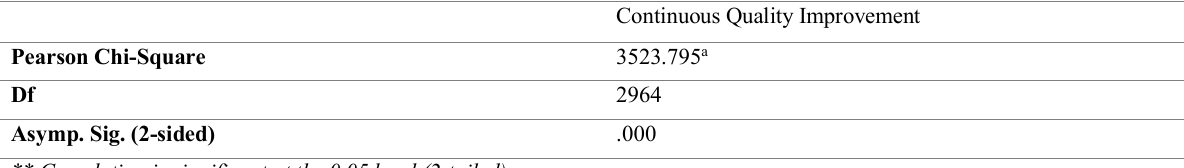
Table 9: Chi-squared test on continuous quality improvement